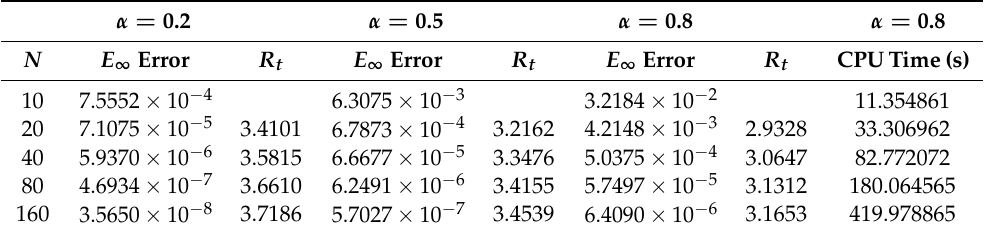
Table 3. E ∞ errors and convergence rates R t for Example 1, when ζ ( t ) = t , ω ( t ) = t + 1, with different α s.